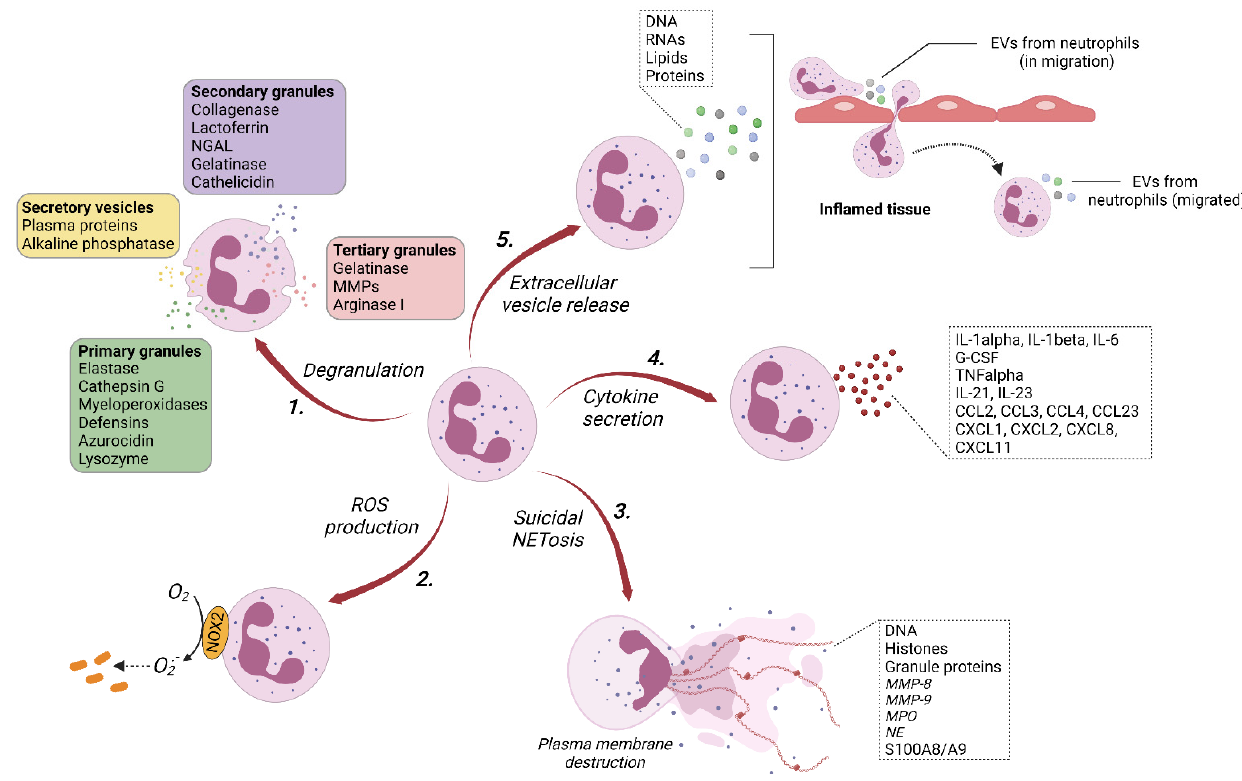
Figure 1. Mechanisms of neutrophil-induced inflammation. Neutrophils dispose of a large arsenal to kill pathogens. This includes 1. degranulation, which corresponds to the release of proteolytic enzymes and cytotoxic proteins [34–37]; 2. the production of different ROS from superoxide anions resulting from the activation of NADPH oxidase 2 (NOX2) [38–40]; 3. the formation of neutrophil extracellular traps (NETs), which are associated with chromatin decondensation and the extrusion of histones, and DNA meshes decorated with granular proteins [41–44]; 4. the secretion of a large panel of cytokines (non-exhaustive list) with proinflammatory/chemotactic/immunoregulatory func- tions [45,46]; and 5. the release of extracellular vesicles loaded with cargo proteins. A dysregulation or imbalance of these different processes fosters the propagation and perpetuation of inflamma- tion, contributing to the development of chronic diseases. All figures were created using Biorender (https://biorender.com, accessed on 21 April